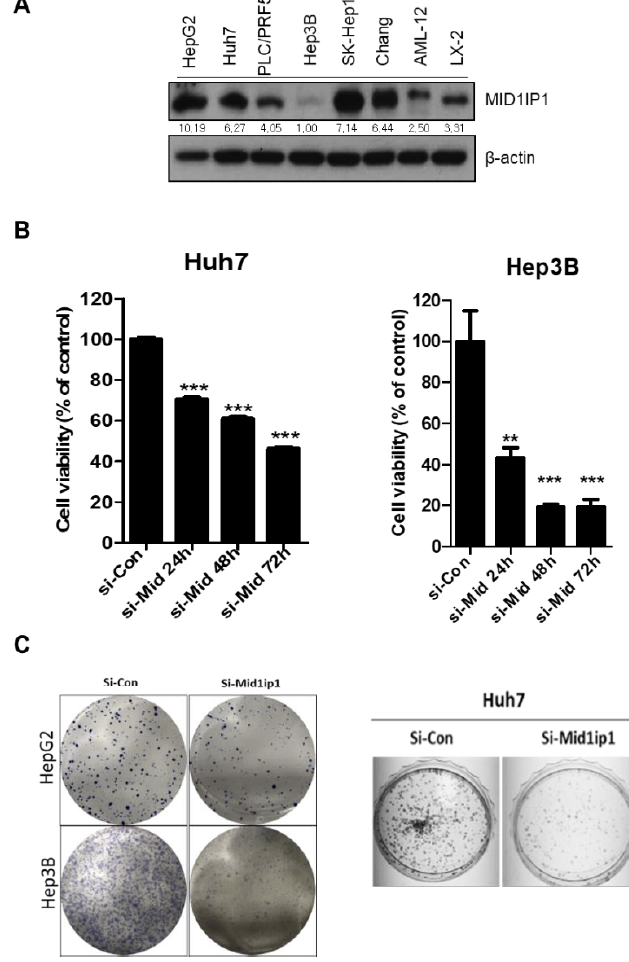
Figure 1. Endogenous expression levels of MID1IP1 in a variety of cells and effect of MID1IP1 depletion on the viability and the number of colonies in HCCs. ( A ) MID1IP1 protein level in various liver cancers and normal cells was detected by Western blotting. ( B ) Effect of MID1IP1 depletion on the viability of Huh7 and Hep3B cells. Huh7 and Hep3B cells transfected with MID1IP1 siRNA or negative control siRNA were incubated overnight at 37 °C for 0, 24, 48, 72 h and then exposed to 30 μL of MTT solution and the optical density values were measured in Biorad microplate reader model 680 (Biorad, USA) at 570 nm. ( C ) Effect of MID1IP1 depletion on the proliferation of HepG2 and Huh7 cells. HepG2, Huh7 and Hep3B cells transfected with MID1IP1 siRNA or negative control siRNA were incubated for 1 week and then the colonies were stained with Diff Quick solution 2 (Cat No.38721, Sysmex corporation, Japan), dried overnight and counted. ** p < 0.01, *** p < 0.001 vs. siRNA-Control. Values of Western blot images represent relative level of protein expression / β